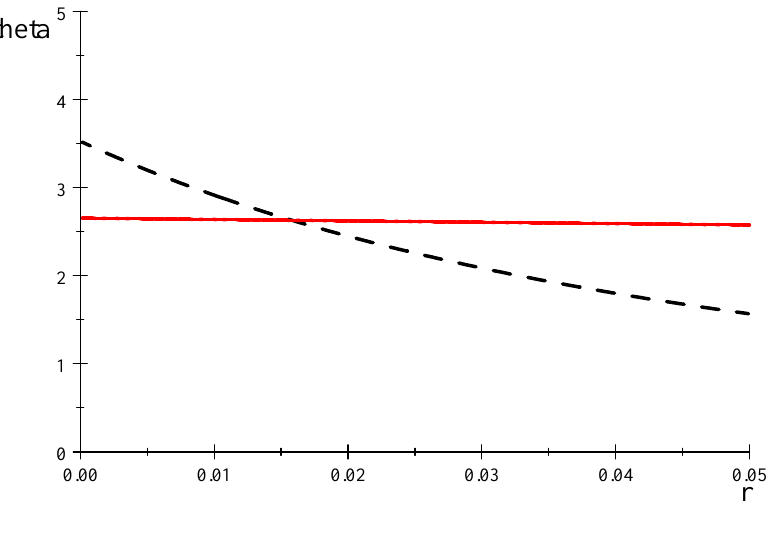
Figure 7: Changes of labour market tightness with respect to the real interest rate: